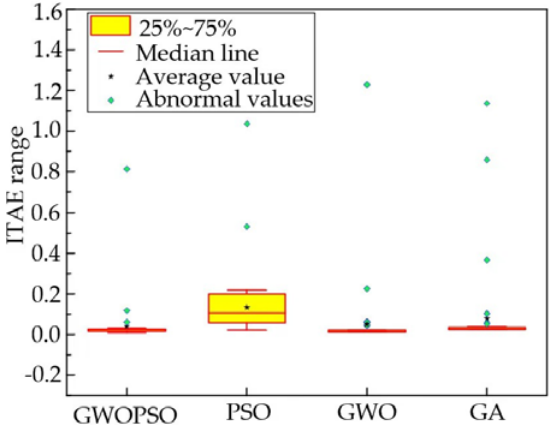
Figure 12. Sudden − varying load response of the PMSS. ( a ) Simulation results; ( b ) experimental re- sults.